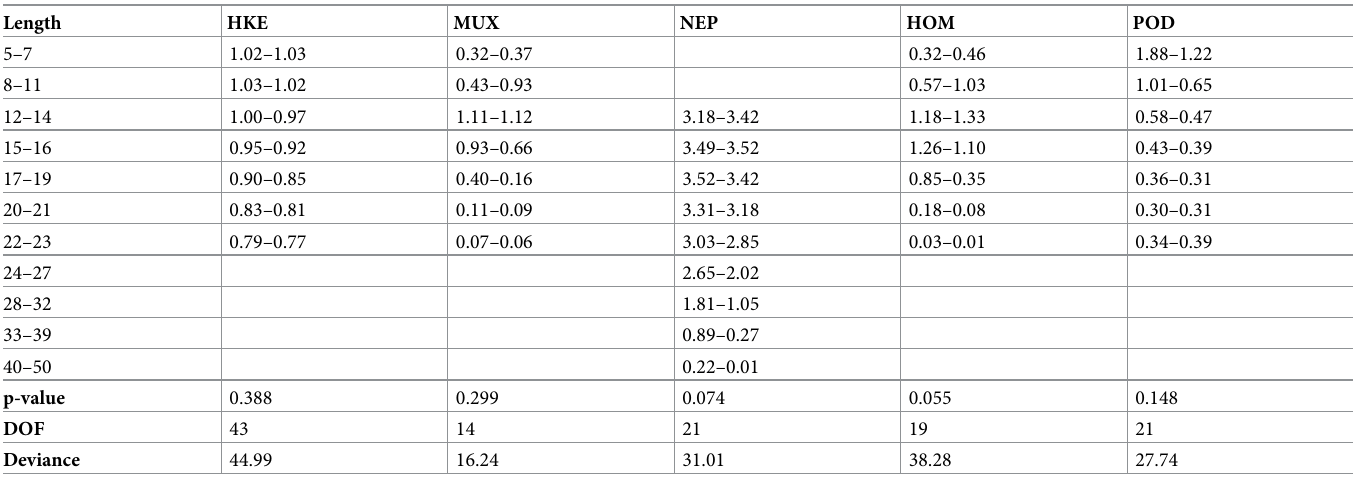
Table 3. Estimated values of mean catch ratio cr ℓ for length class ℓ .